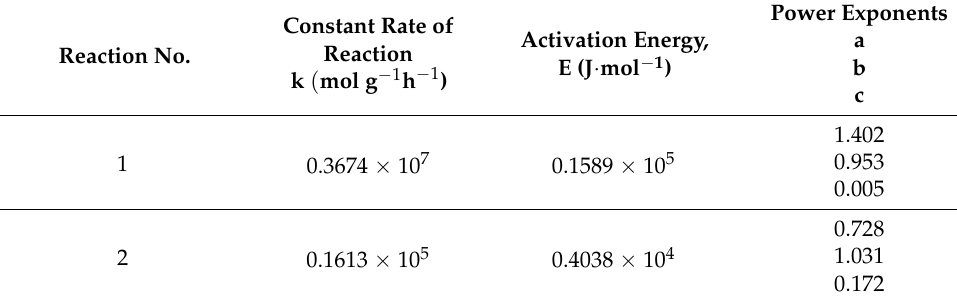
Table 1. Parameters of reaction kinetic models [14].